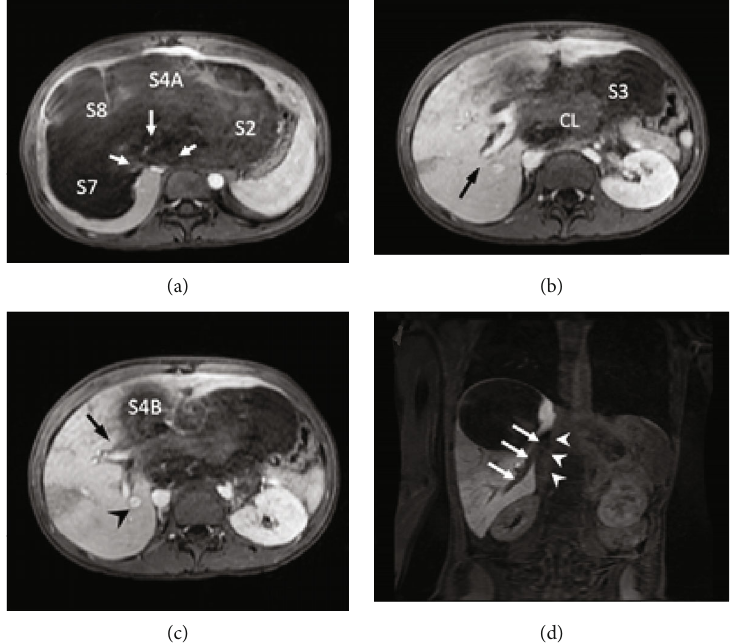
Figure 2: MRI Images. (a) Axial T1 weighted: tumor involvement of major hepatic veins (arrows) and liver segments 2, 4A, 7, and 8. (b) Axial T1 weighted: tumor involvement of segment 3 and caudate lobe; right posterior portal vein is free (arrow). (c) Axial T1 weighted: tumor involvement of segment 4B and the right anterior portal vein (arrow); IRHV entering segment 6 (arrowhead). (d) Coronal T1 weighted, 20-minute hepatobiliary phase: view of the IRHV in segment 6 (arrows) draining into the IVC